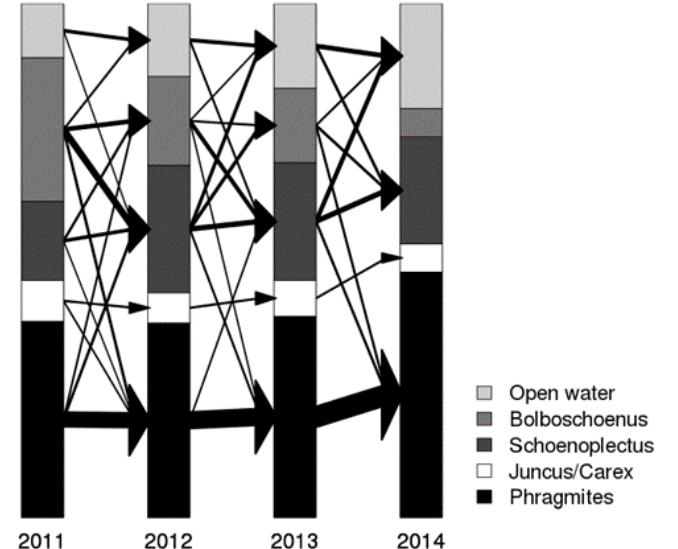
Figure 6. Succession trajectories for the five vegetation classes in the second to fifth years after rewetting. Arrows are scaled according to the area proportions of the respective paths. Only arrows representing more than 5 % of the total area are